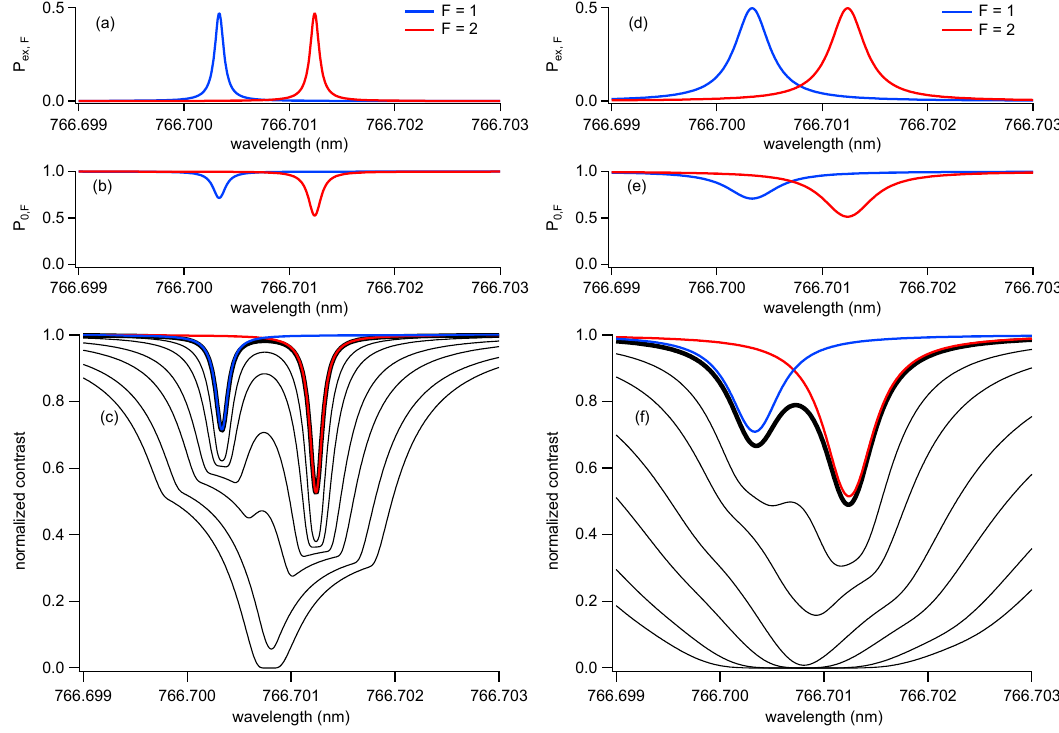
Figure 3. Decoherence spectroscopy model. Graphs ( a , d ) show the probability of finding atoms in an excited 4 p state of 39 K while exposed to laser light with wavelength λ = 2 π c / ω and irradiance such that Ω Rabi = 6 Γ ( a ) or 24 Γ ( d ). Graphs ( b , e ) show the probability of scattering zero photons ( P 0, F ) after atoms pass through a laser beam, as described by Equation (7) with an interaction time of T = 3/ Γ , and Ω = 6 Γ or 24 Γ , respectively. Graphs ( c , f ) show Contrast after passing through multiple laser beams Rabi as described by Equation (9) with parameters θ = 1.3 mrad, δ = 0. The red and blue curves show the contrast for the atoms in a specific F level with a single laser beam ( p = 0), and the solid black curve shows the combined contrast for the ensemble of atoms. The thinner black curves show the contrast for varying number of laser beams interacting with the atom beam, using ( − N ≤ p ≤ N , with N = 1, 3, 9, 18, 35, or